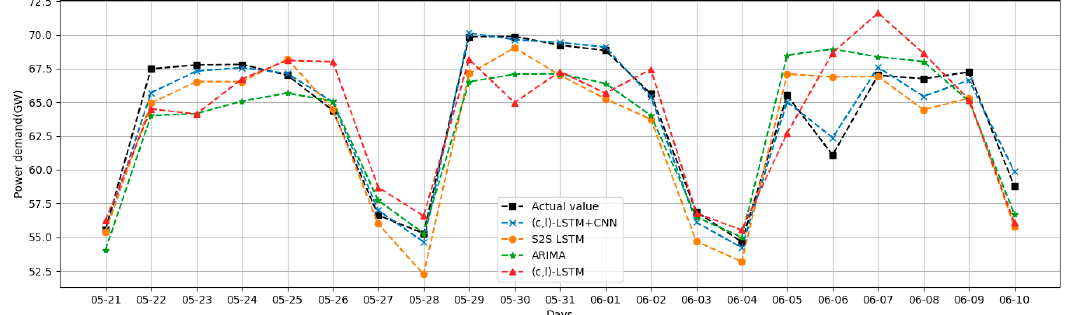
Figure 17. Forecasting a 21-day profile.